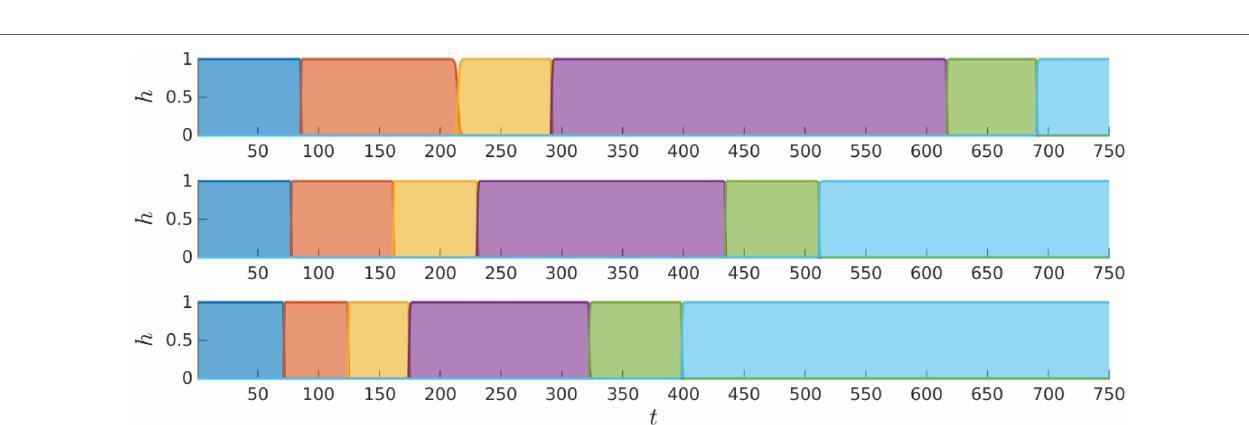
FIGURE 3 | Evolution of the rescaled forward variable h t,i , where each plot corresponds to a different initial bottle weight, which decreases from the uppermost to the lowermost plot